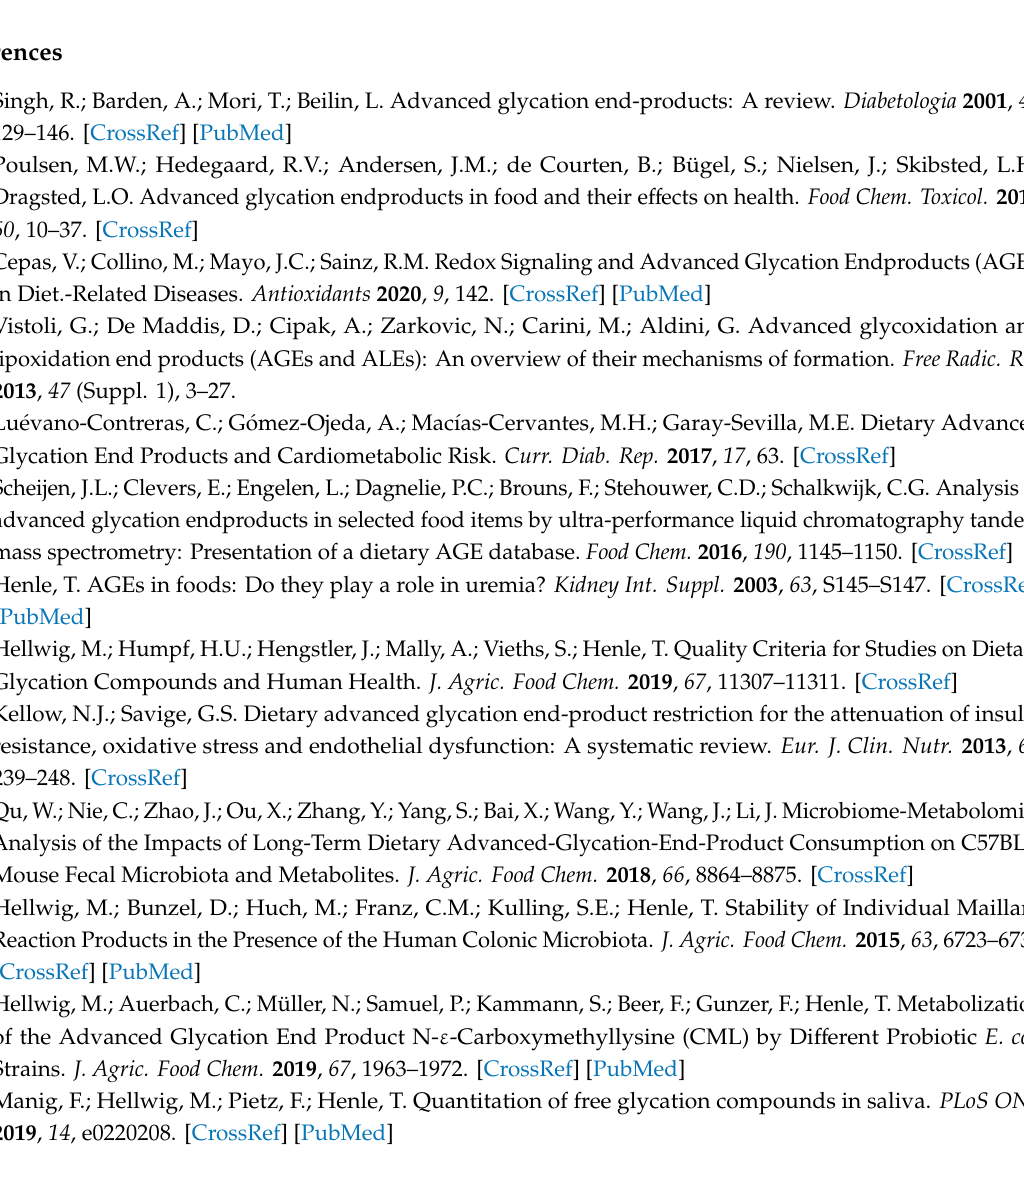
Table S1: lectin microarray composition list and lectin